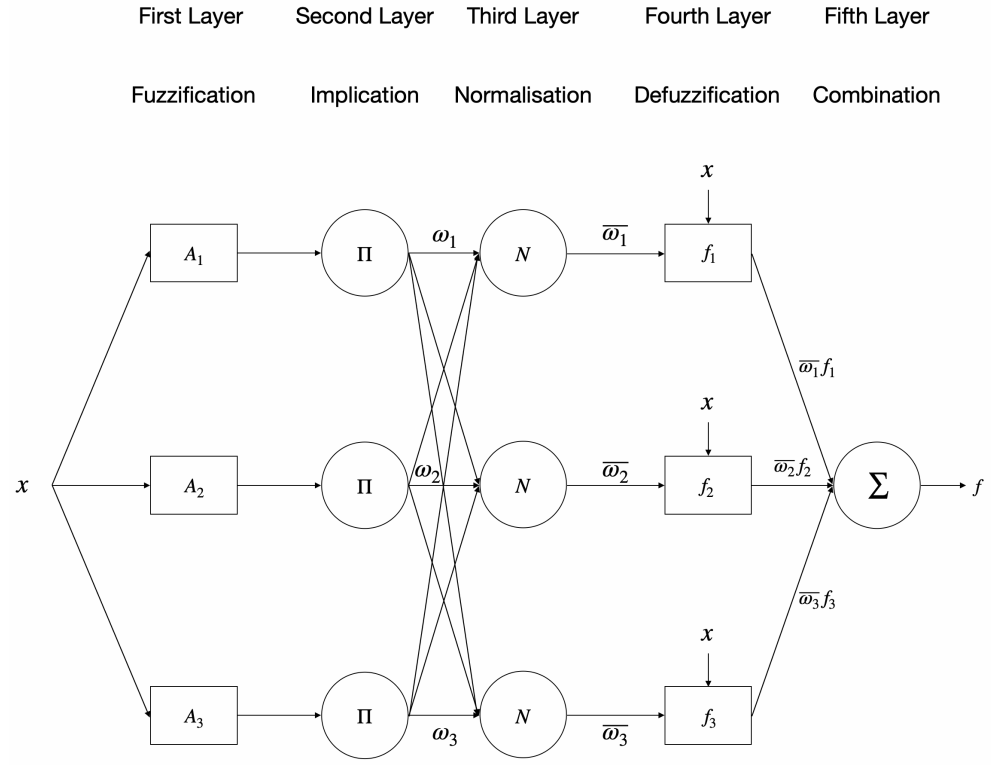
Figure 3. Architecture diagram of the adaptive neuro-fuzzy inference system (ANFIS)